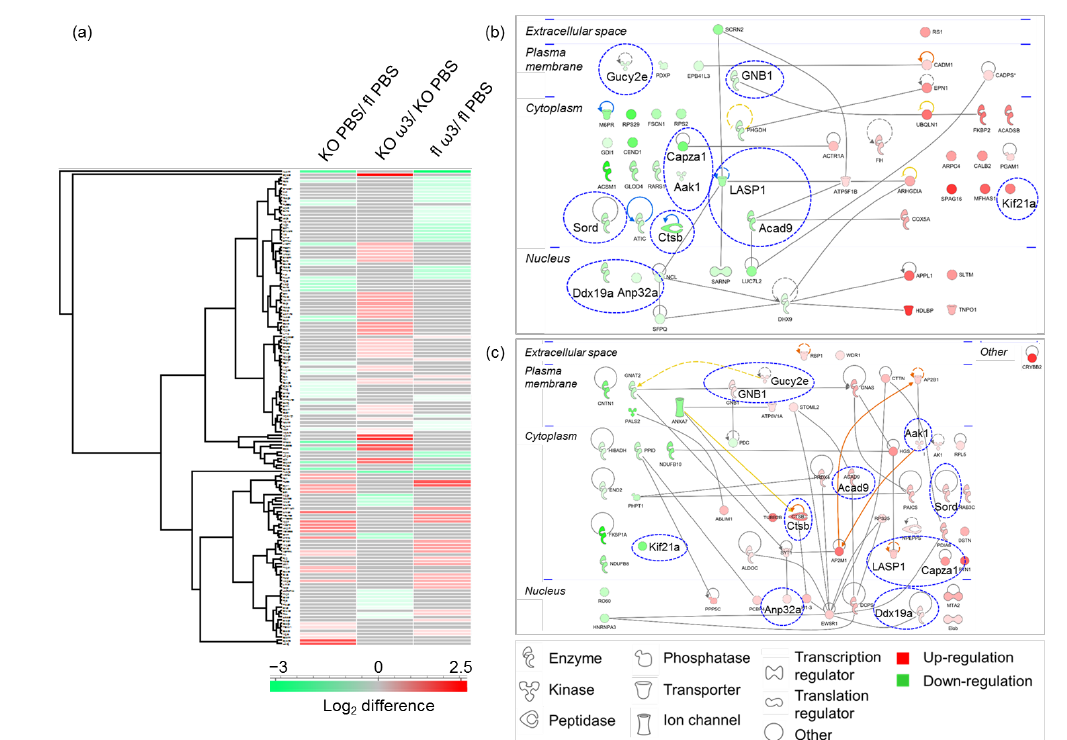
Figure 4. Profiles of differentially expressed retinal proteins. ( a ) Heat map depicts the hierarchical clustering of the differentially expressed retinal proteins. Red and green shading indicate up- and down-regulation of the proteins, respectively. The protein – protein interaction networks of differentially expressed proteins in the retina of the KO mice ( b ) before and ( c ) after 7-days of ω -3 PUFA intake. Nodes (proteins) depicted with different shapes represent functional classes of the proteins (e.g., enzyme, transcription regulator, transporter, etc.) and are annotated according to their localization in different cellular compartments. The intensity of the node colour indicates the degree of differential regulation, with the colours red and green representing the increment and decrement of protein abundance, respectively. Blue dotted circles highlight the distinct alteration in protein regulation profiles following ω -3 PUFA supplementation.